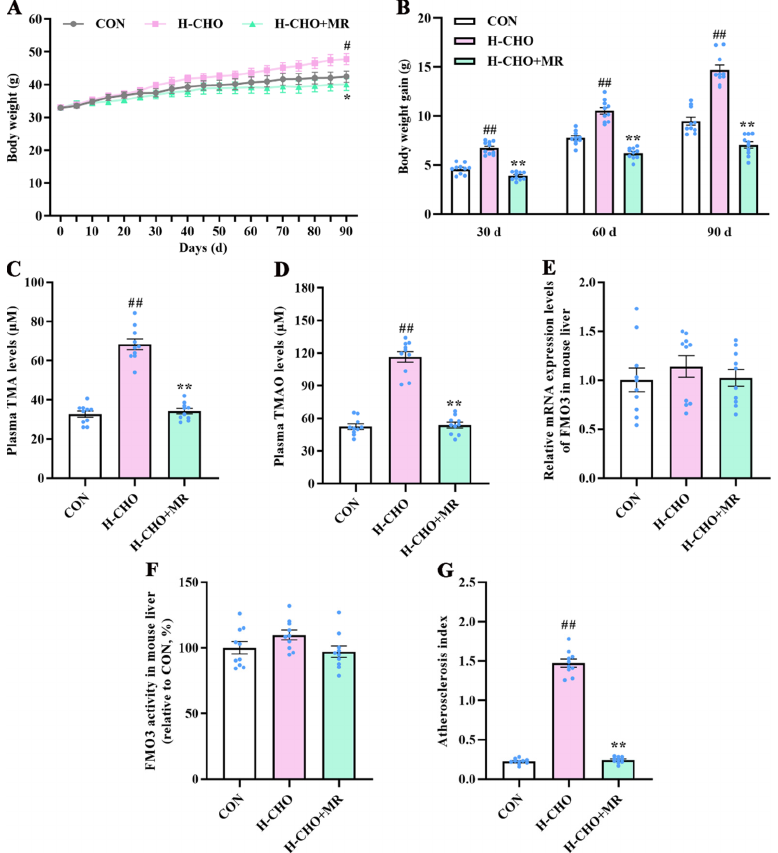
Figure 2. Effects of MR on body weight ( A ), body weight gain ( B ), plasma TMA ( C ) and TMAO levels ( D ), hepatic FMO3 gene expression levels ( E ) and activity ( F ), and atherosclerosis index ( G ) in mice under H-CHO diet conditions. MR, methionine restriction; CON, normal diet group; H- CHO, high-choline diet group; H-CHO+MR, high-choline + methionine restricted diet group. # p < 0.05, ## p < 0.01 (H-CHO vs. CON); * p < 0.05, ** p < 0.01 (H-CHO+MR vs. H-CHO).